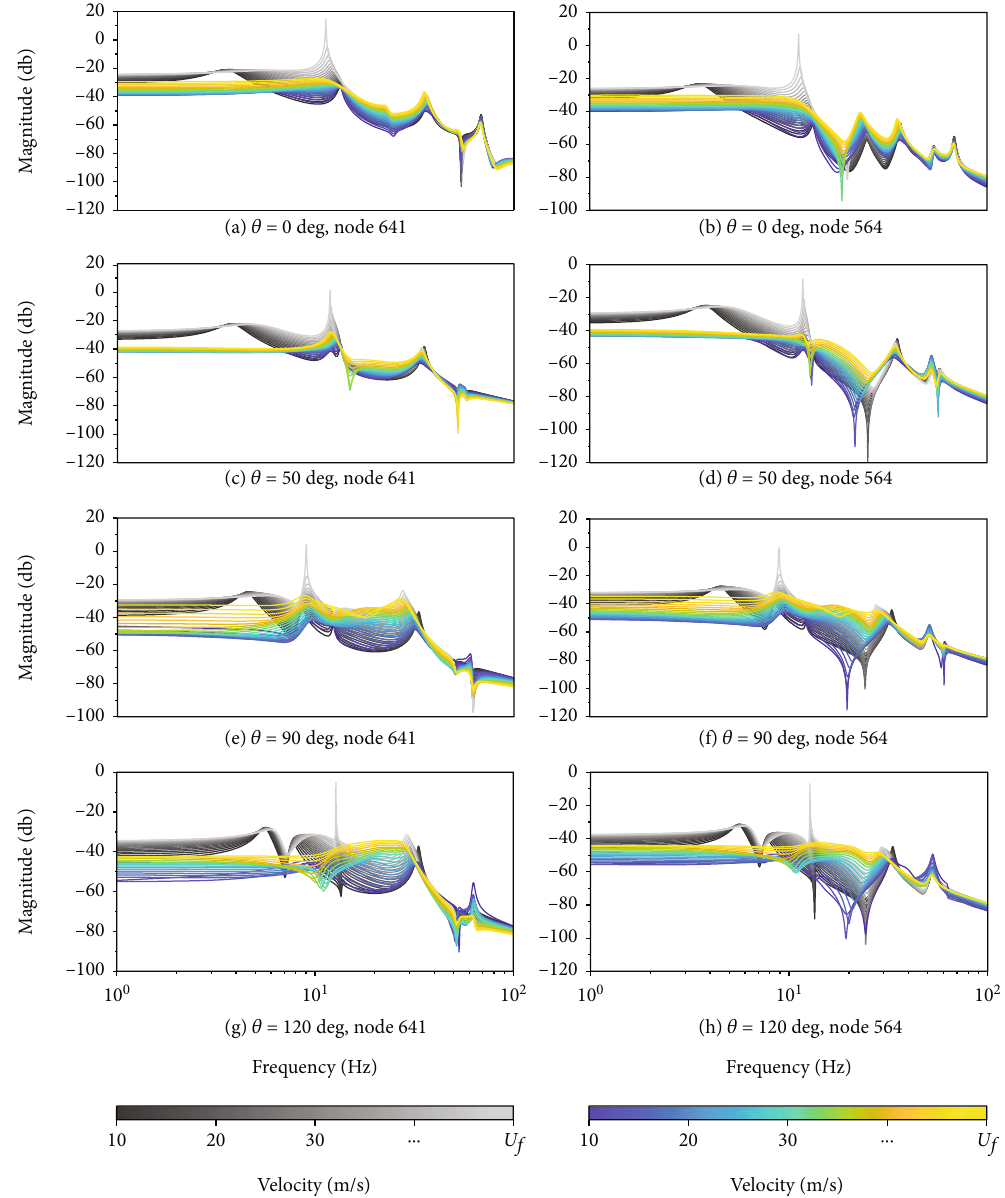
Figure 17: Frequency responses of the open-loop (black line/gray line) and closed-loop (blue line/yellow line) systems from the vertical gust disturbance to the displacements of structural